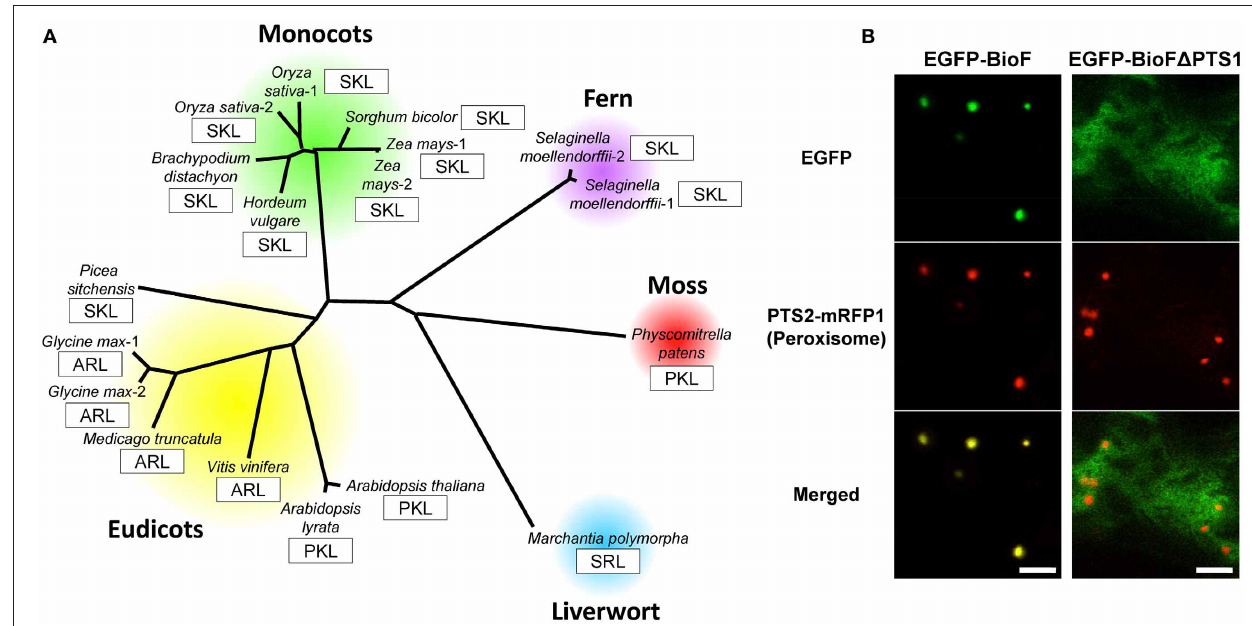
FIGURE 7 | Phylogenetic relationship and peroxisomal localization of plant BioF proteins. (A) Phylogenetic analysis of plant BioF proteins (Maruyama et al., 2012). The amino acid residues of C-terminal peroxisomal targeting signals (PTS1) are indicated by open boxes. The full-length amino acid sequences of the plant BioF proteins were aligned using the method described in Figure 5 . The Genbank accession numbers for the sequences used in the analysis are as follows: Arabidopsis thaliana , NP_974731.1; Arabidopsis lyrata , XP_002871105.1; Oryza sativa -1, BAD87813.1;